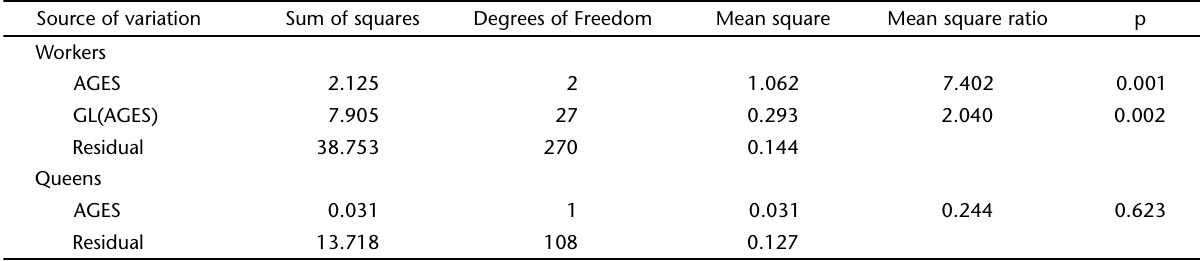
Table I. Variance analysis (ANOVA) of the alveolar area from cephalic salivary glands of A. mellifera workers and queens. Note the significantly difference p value (p (cid:2) 0.05) among workers of different and also within each workers group. There is non-significant difference (p > 0.05) between virgin and egg-laying queens. Significance p (cid:2) 0.05. Source of variation Sum of squares